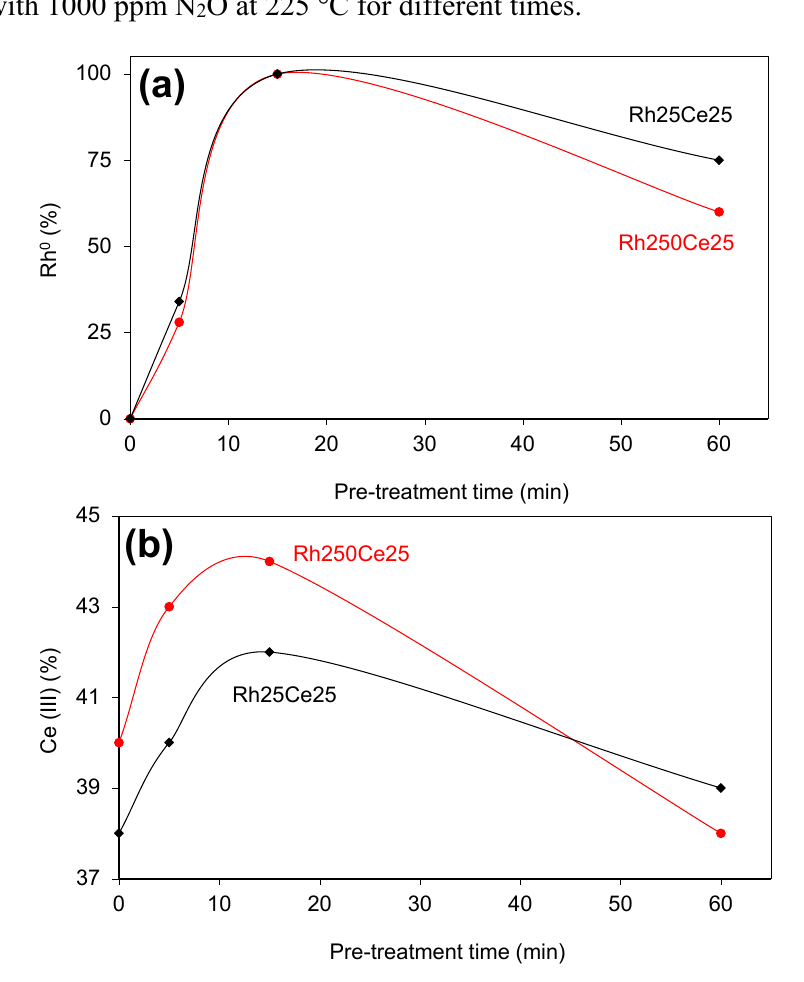
Figure 6. ( a ) Rh (0) and ( b ) Ce (III) percentages determined by XPS after in situ thermal treatments with 1000 ppm N 2 O at 225 °C for different